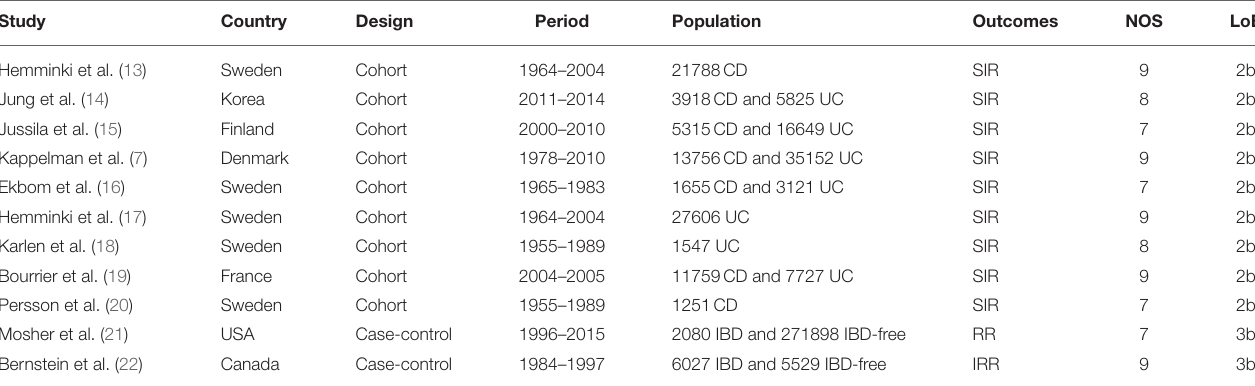
TABLE 1 | Characteristics of included literature on bladder cancer in patients with inflammatory bowel